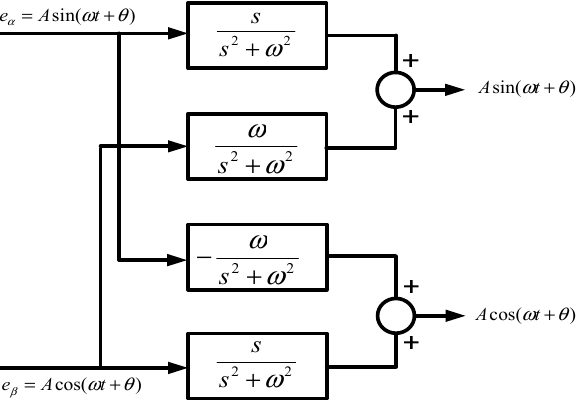
Figure 6. Positive-sequence of alpha and beta axes.